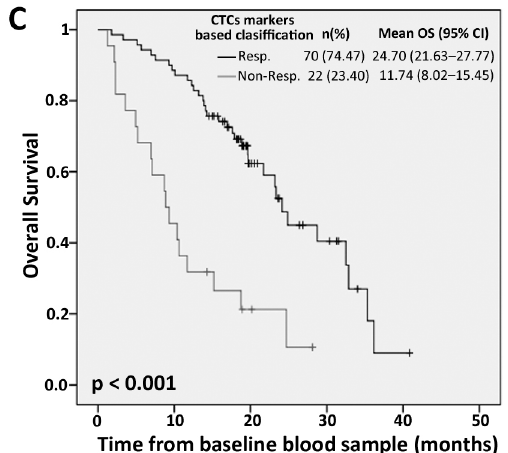
Figure 2. Kaplan-Meier curves showing progression-free survival (PFS) and overall survival (OS) based on the classification of patients as responders (Resp.) or non-responders (Non-Resp.) according to changes in circulating tumor cells (CTCs) gene expression levels with the treatment. ( A ) Classification of patients at the times of blood sample collection, according to PrediCTC. Kaplan-Meier curves for ( B ) PFS and ( C ) OS.